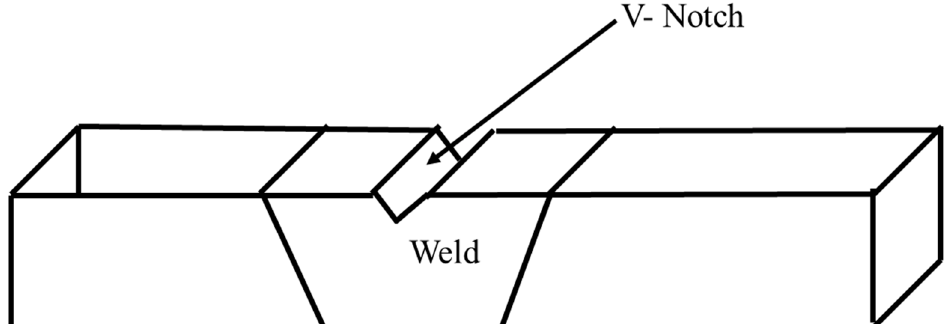
Figure 5. Location of V-notch in the impact testing specimen.